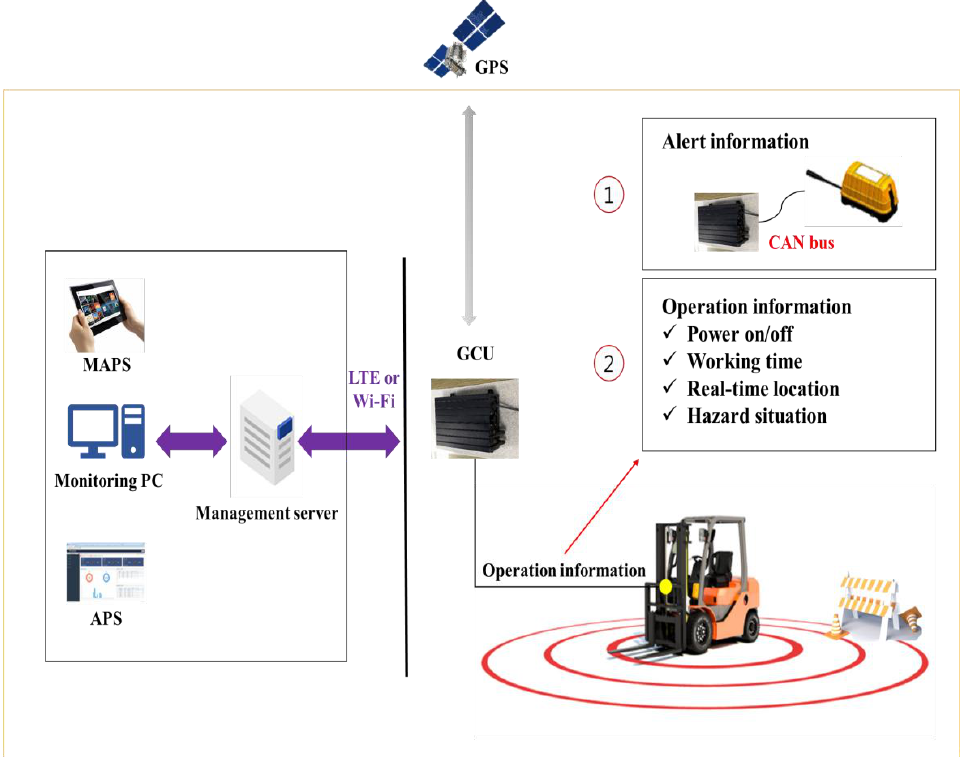
Figure 3. Data collection scenario.